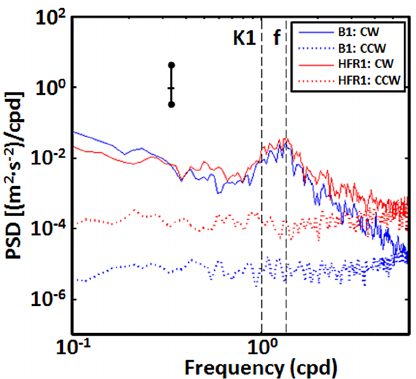
Figure 8. Spectral density of the rotary auto-spectra of the B1 buoy (blue) and HF radar at the closest grid point HFR1 (red), performed for a 6-month period May–October 2014 of concur- rent records. Clockwise (counter-clockwise) components are rep- resented by solid (dotted) lines. Vertical dashed lines indicate the frequencies of the diurnal constituent ( K 1 ) and the inertial oscilla- tions (f) . Error bars indicate the 95% confidence interval.